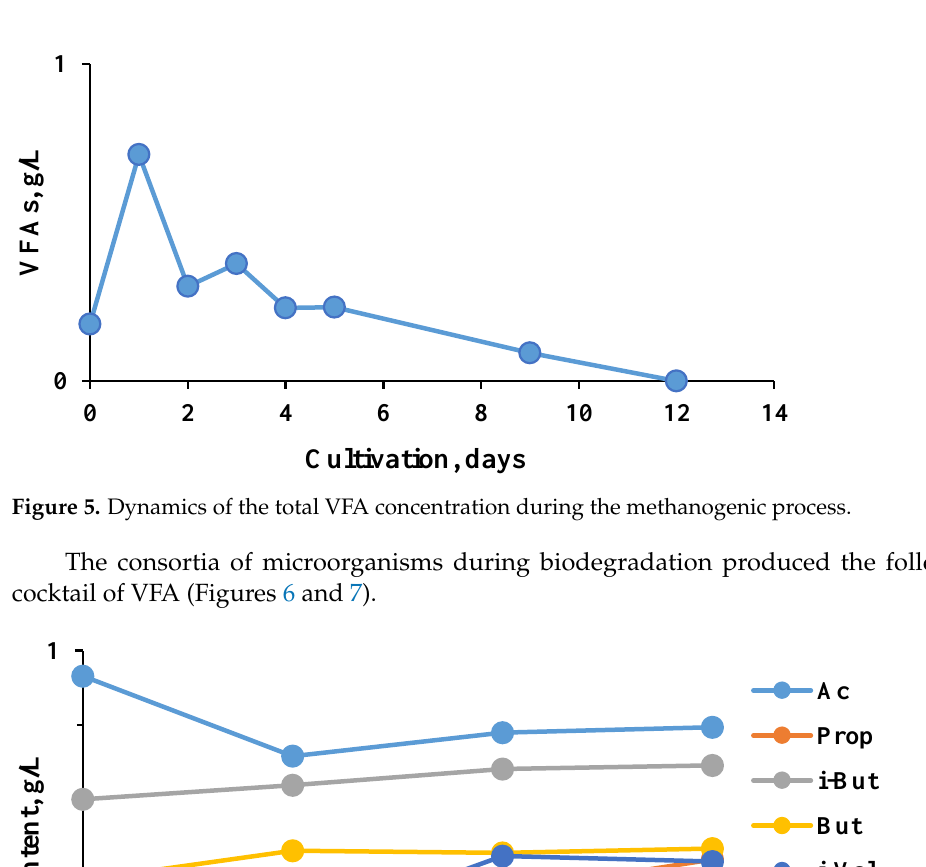
Figure 4. Dynamics of the total volatile fatty acid (VFA) concentration during the hydrogen produc- tion process.